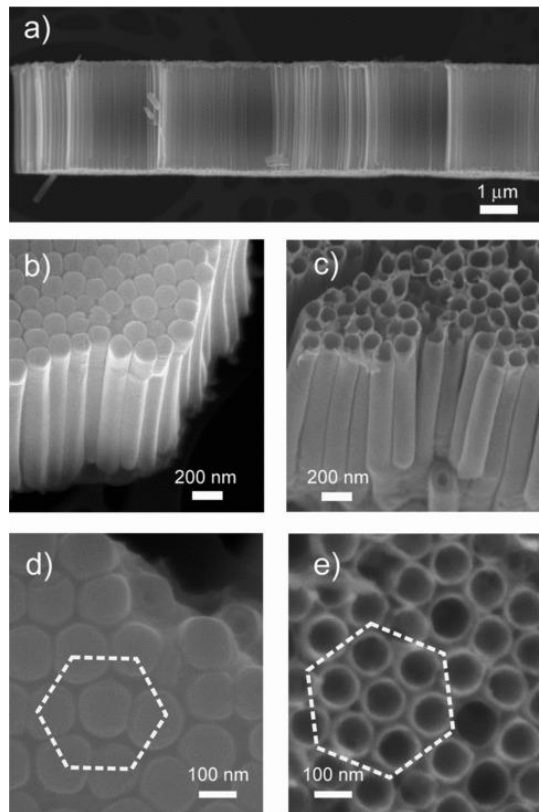
Figure 4. SEM images of TiO 2 nanotubes at different magnifications. ( a ) The self‐standing nanotube array after detachment from the substrate highlights the perfect alignment of the tubes. Lateral views from ( b ) the bottom and ( c ) the top. As is typically expected in anodization processes, the tubes are closed at the bottom. Plane view of ( d ) the bottom and ( e ) the top of the nanotube array. The short-range ordered, close-packed hexagonal assembly can be clearly distinguished. Reproduced with permission from [16].